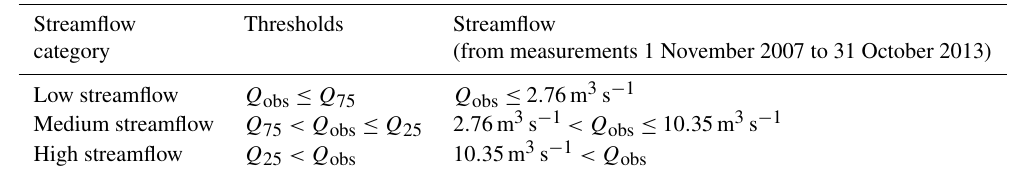
Table 1. Definition of streamflow categories.